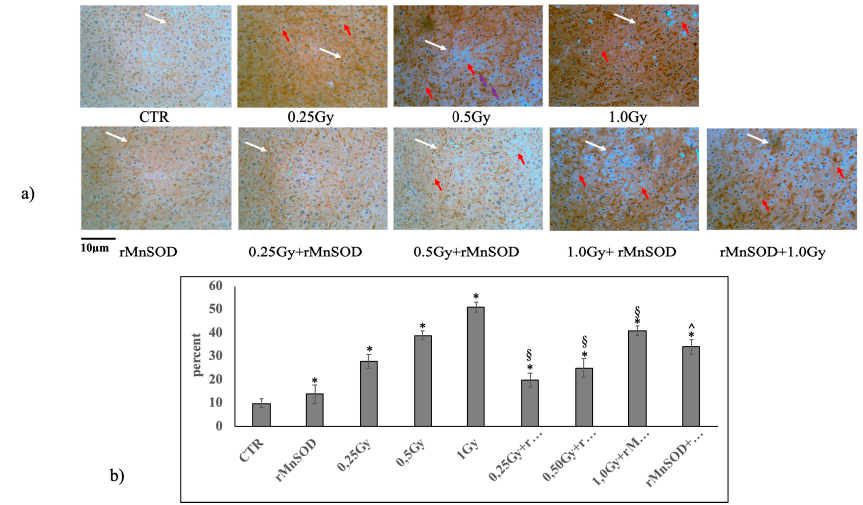
Figure 1 . Mouse liver after irradiation with or without protective or preventive rMnSOD treatment ( a ) representative liver histology by Caspase-1 immunohistochemical staining. CTR, control mice; rMnSOD, mice treated with human recombinant manganese superoxide dismutase; 0.25 Gy, 0.5 Gy, and 1.0 Gy, mice exposed to increasing radiation doses; 0.25 Gy + rMnSOD, 0.5 Gy + rMnSOD, and 1.0 Gy + rMnSOD, mice exposed to increasing radiation doses and treated with rMnSOD (protective role of rMnSOD); rMnSOD+1.0Gy, mice pretreated with rMnSOD and exposed to 1.0 Gy radiation (preventive role of rMnSOD). Images are representative of 3 similar images from each group of mice (20× magnification). White arrows indicate positive caspase labelling; red arrows indicate cell membrane ruptures. ( b ) Quantification of Caspase-1 staining was performed using the ImageFocus software. Positive staining is indicated as low (+), medium (++), or high (+++). Only high positive staining was considered and was measured as a percentage of the total area. Data represent the mean + S.D. of three livers for each group. Significance, * p < 0.05 with respect to the CTR, § p < 0.05 with respect to the irradiated samples, ˆ p < 0.05 with respect to 1.0 Gy +